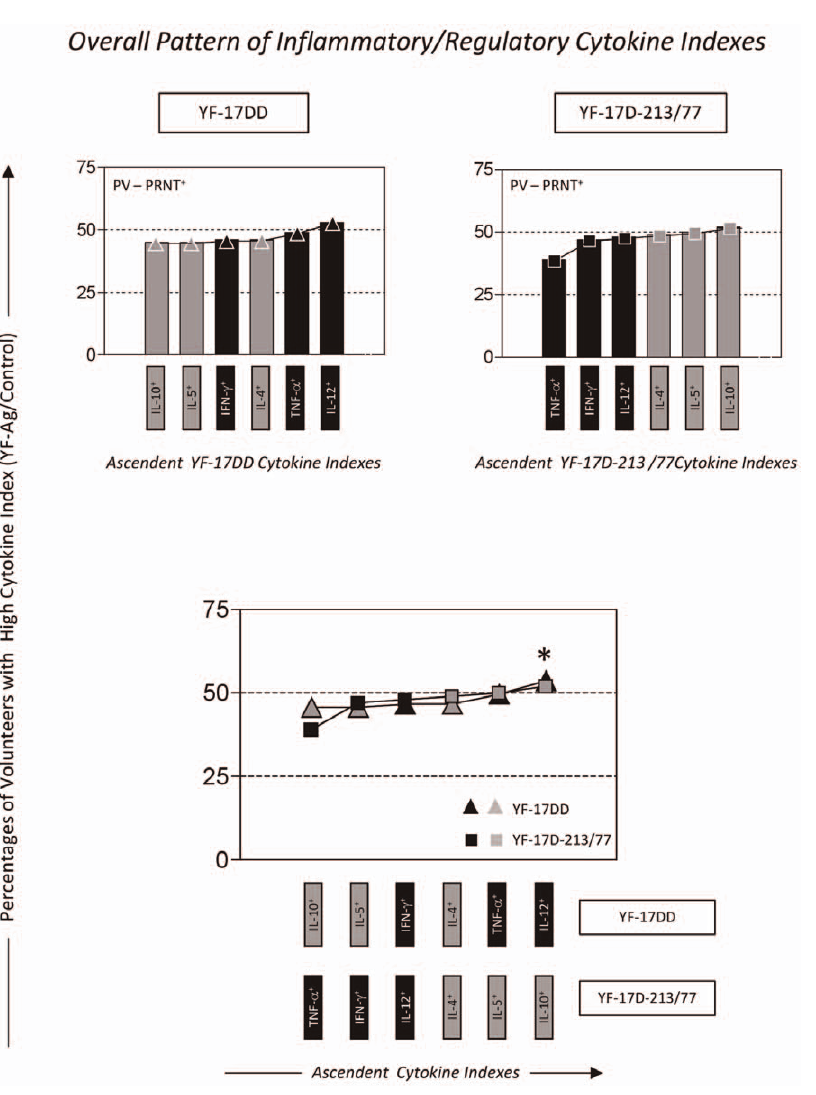
Figure 2. Overall inflammatory and regulatory cytokine pattern triggered by the YF-17DD and YF-17D-213/77 substrains upon the in vitro recall of whole blood leukocytes from seroconverter children (PV-PRNT + ) with specific YF-Ag. The overall pattern of inflammatory (black bar) and regulatory (gray bar) cytokines is presented as the ascendant percentages of volunteers with high cytokine indexes, taking the cytokine profile of the whole leukocyte population (neutrophils, monocytes, and lymphocytes) for each experimental arm. Comparative analysis of the overall cytokine patterns from YF-17DD (lines with black or gray triangles) and YF-17D-213/77 (lines with black or gray squares) vaccines were further compared by overlapping the ascendant cytokine curves (bottom panel). Dotted lines highlight the 25 th and 50 th percentiles used as reference for comparative analysis. *Relevant differences were considered when the frequency for a given cytokine emerged outside the 50 th percentile as compared to the reference cytokine pattern or signature.